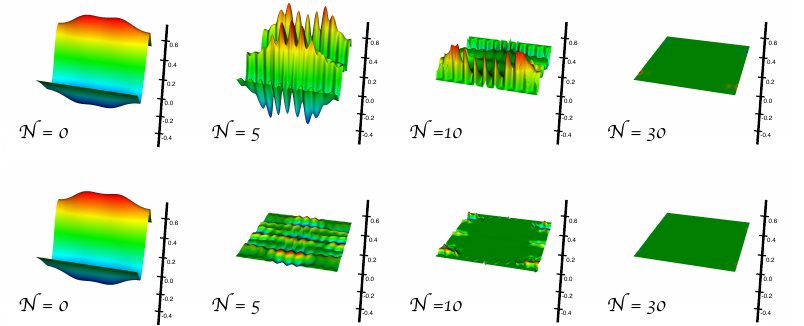
Figure 1. Upper panel: N = const. snapshots of the diagonal 11-component ¯ n 11 of the intrinsic (spatial) curvature tensor ¯ n ab corresponding to the simulation first presented in Ref. [6] with the initial average velocity Q 0 = 0.1. Lower panel : pure gradient contributions to ¯ n 11 . The time coordinate N marks the number of e -foldings of contraction in the Hubble radius H − 1 . Notably, complete smoothing of the initial patch is reached by only 30 e -folds of